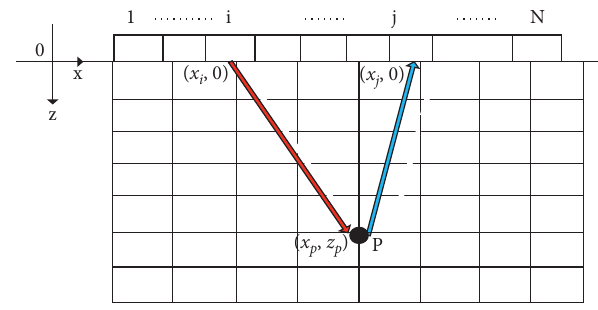
Figure 1: Schematic diagram of FMC and TFM.